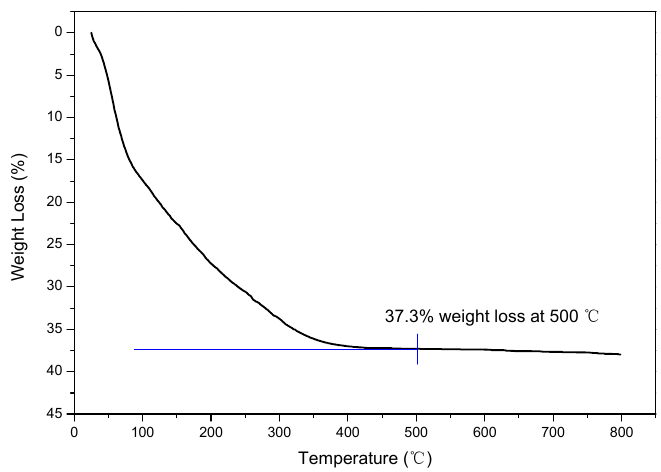
Figure 1. Thermogravimetric (TG) curves of the hydrous ZrO 2 membrane.